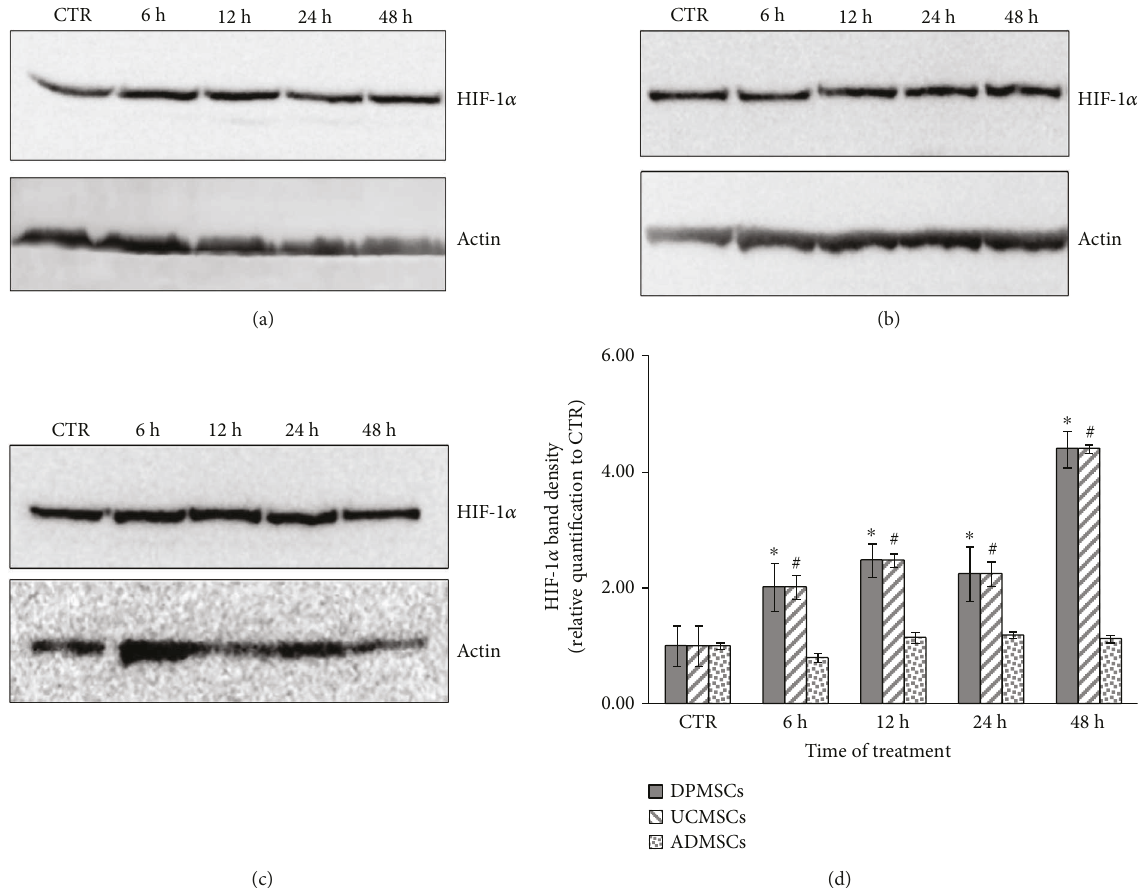
Figure 2: E ff ect of CoCl in the expression of HIF-1 α . The MSCs were incubated with 100 μ M of CoCl in cell medium supplemented with 2% 2 2 of FCS for 6 h, 12h, 24h, and 48h. (a) HIF-1 α expression in the DPMSCs; (b) HIF-1 α expression in the UCMSCs; (c) HIF-1 α expression in the ADMSCs; (d) densitometric analysis of western blot bands. Control samples consist in the MSCs cultured with cell medium supplemented with 10% FCS for 48 h. The value was normalized to each corresponding β -actin level and represented as a relative expression compared to the control sample. Each value is the mean ± SD of triplicate independent experiments. ∗ p < 0 05 , as compared to control DPMSCs; # p < 0 05 , as compared to control UCMSCs; § p < 0 05 , as compared to control